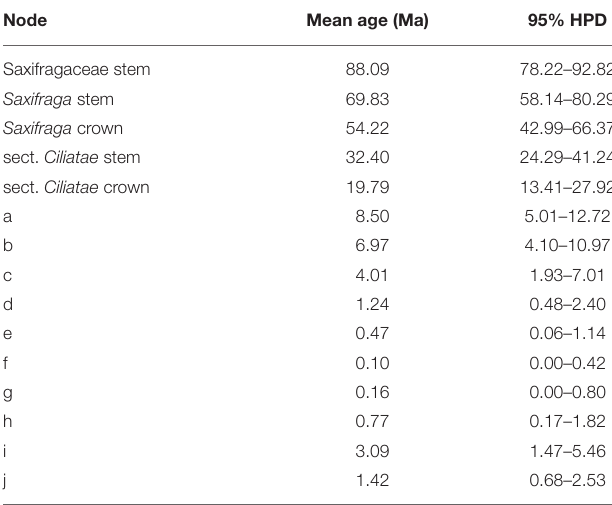
TABLE 6 | Estimation of divergence times for consistent and robust nodes of ITS genotypes of Saxifraga umbellulata and S. pasumensis s.l. Node Mean age